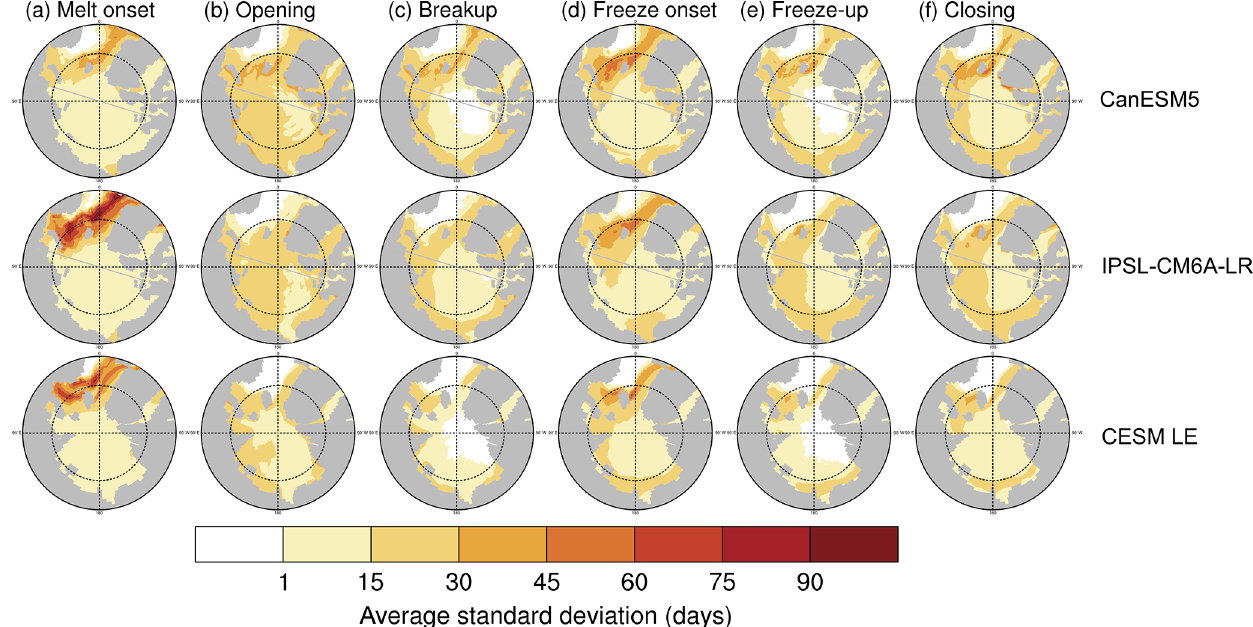
Figure 8. The average standard deviation between the first 30 ensemble members over the period 1979–2014 for (a) melt onset, (b) opening, (c) breakup, (d) freeze onset, (e) freeze-up, and (f) closing. CanESM5 is displayed in the first row, IPSL is displayed in the second row, and CESM LE is displayed in the third row. The standard deviation is calculated at each grid cell for each year, and then the average of all years is plotted for each grid cell. The same figure using all available ensemble members of each model is displayed in Fig.